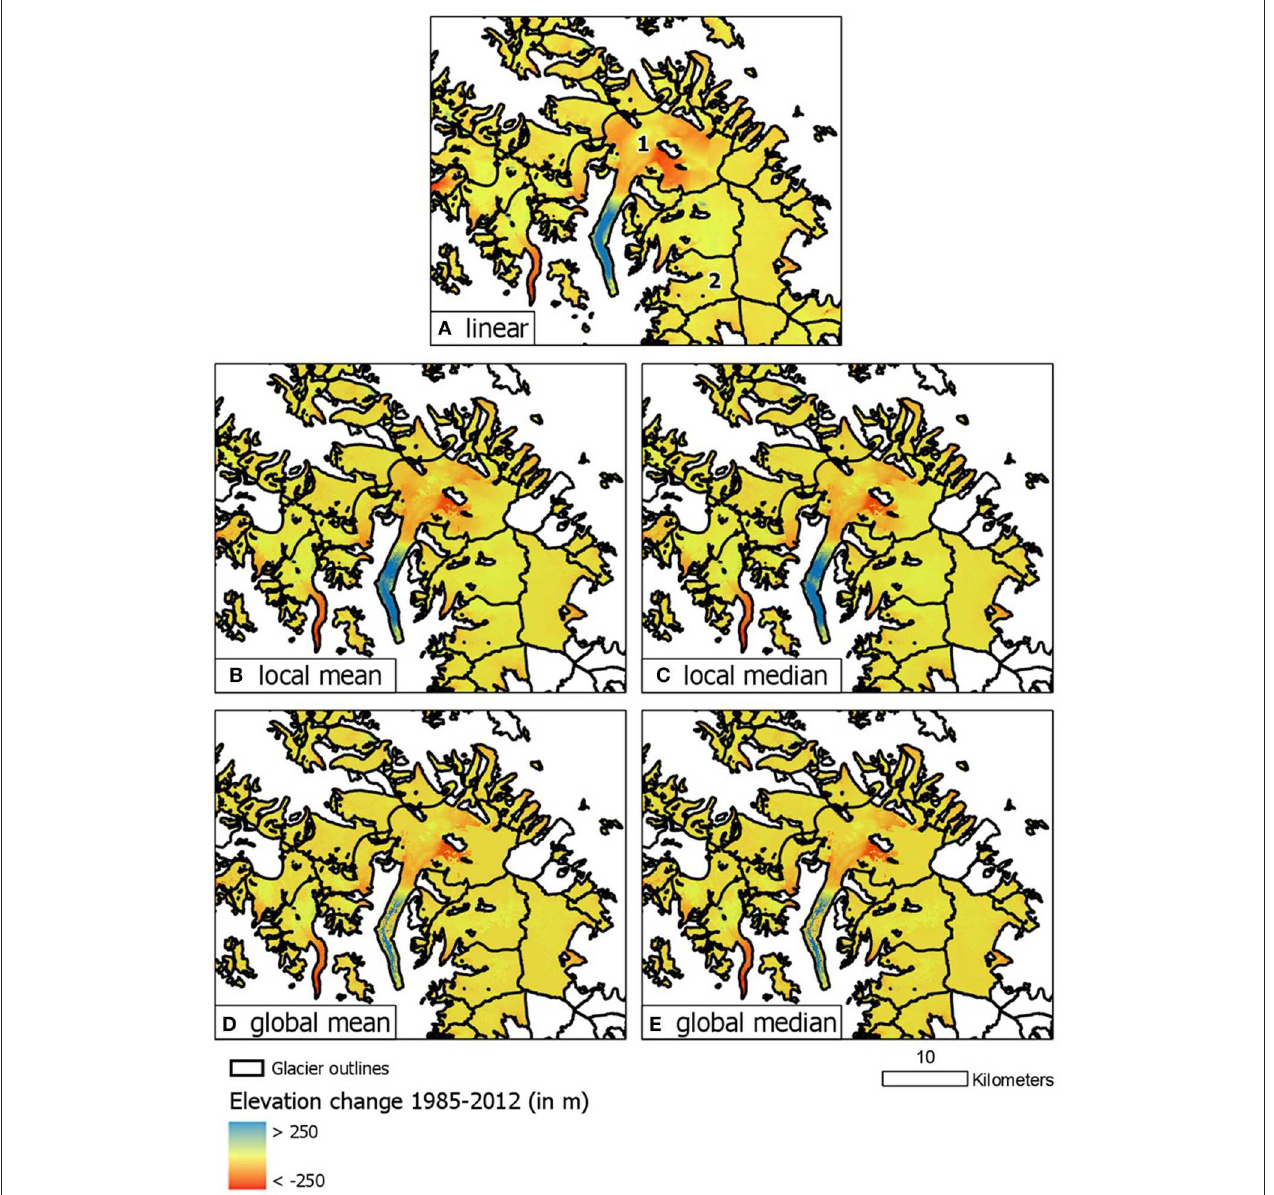
FIGURE 2 | Visual comparison of the DEM differencing resulting from the various void-interpolation methods: (A) linear interpolation of elevation differences, (B) mean elevation difference by elevation bin locally, (C) median elevation difference by elevation bin locally, (D) mean elevation difference by elevation bin globally, (E) median elevation difference by elevation bin globally. In general, the glaciers show elevation losses with higher losses at the tongues whereas the large surging glacier in the middle shows a reversed pattern (elevation gain at the tongue, elevation loss higher up). Note how the different void-interpolation methods influence the elevation change pattern. For instance, the global methods do no generate appropriate results for the surging glacier. In case a glacier had a large fraction of voids, no elevation changes have been calculated (white glaciers, cf. methods). Glaciers 1 and 2 in (A) refer to the results in Table 1